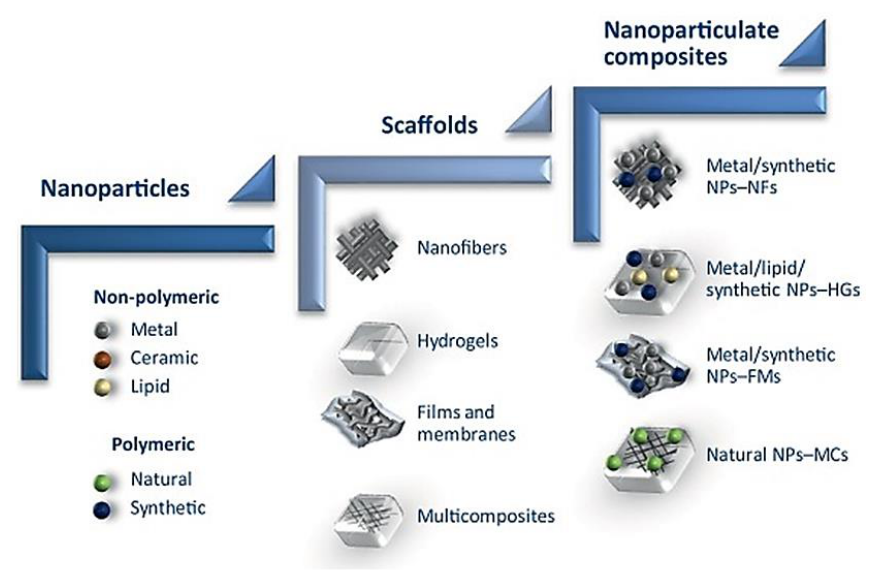
Figure 5. Schematic of nanomaterial, from nanoparticle to nanoparticulate system for wound